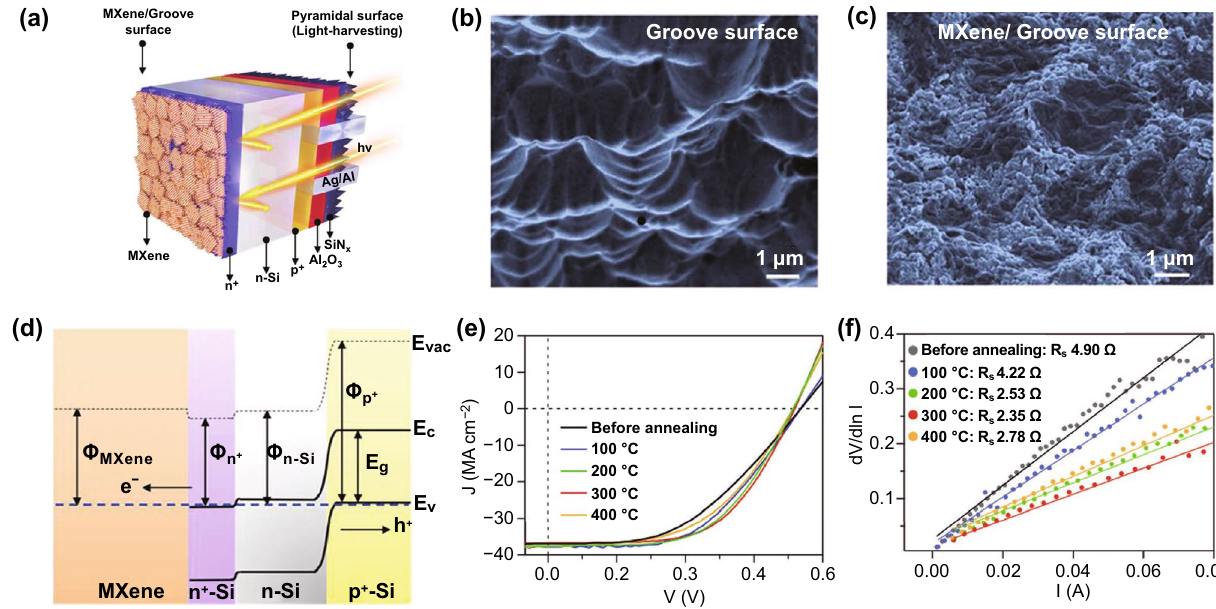
Fig. 7 a Schematic illustration for the n + – p – p + Si solar cell using the Ti 3 C 2 T x MXene as the electrode contacted with the n + emitter. SEM images of grooves on the n + side surface b before and c after MXene coating. d Energy-level alignment. Φ is a work function; E g , E c and E v are the energy bandgap, conduction band and valence band of Si. e Illuminated J - V curves before and after 30 s RTA treatment at varying tem- peratures. f Series resistance values deduced from the J – V measurement for the samples before and after the RTA process. Copyright © 2019 WILEY ‐ VCH Verlag GmbH & Co. KGaA,